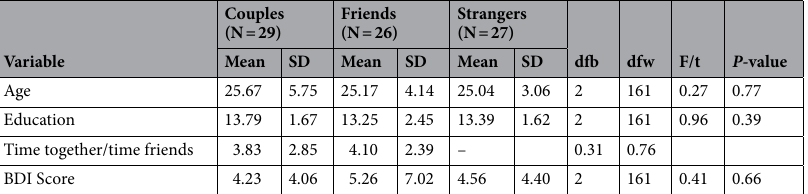
Table 1. Demographic table. Age, education, and time together were measured in years, BDI Beck Depression Inventory.